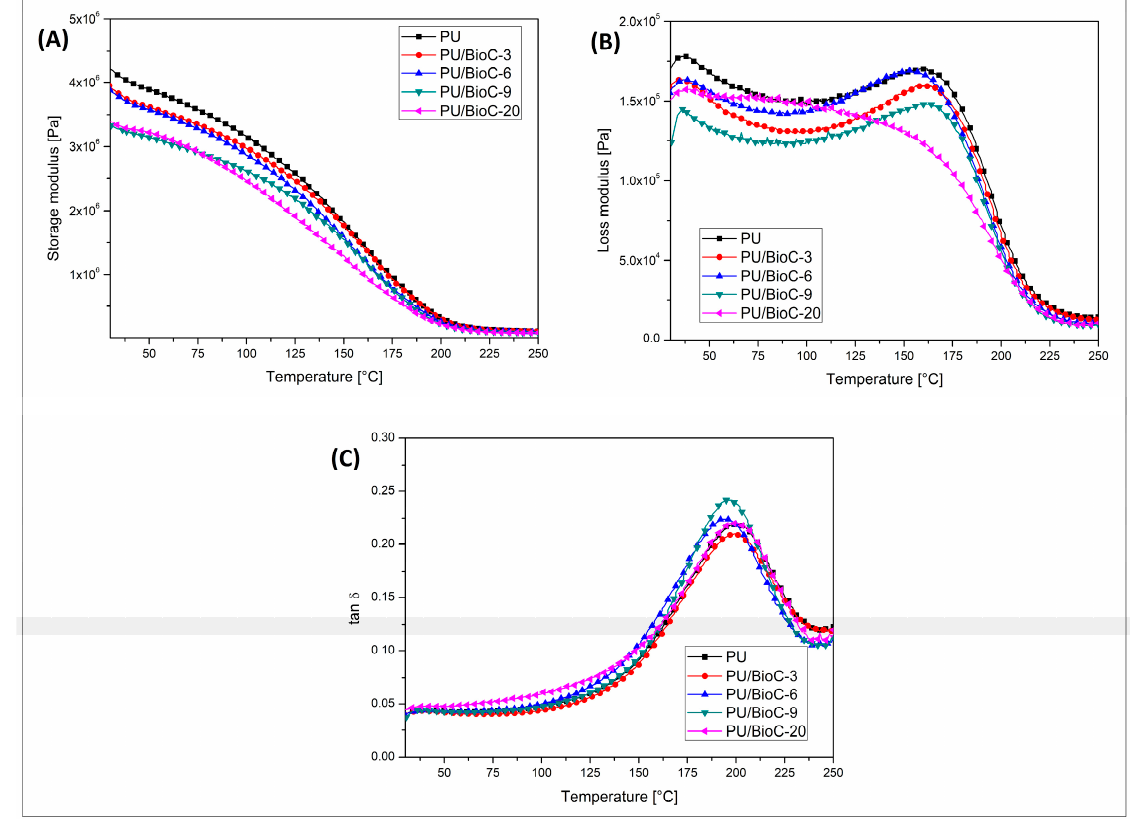
Figure 8. Results of thermomechanical DMTA analysis. ( A ) Storage modulus, ( B ) loss modulus and ( C ) tan δ lots.